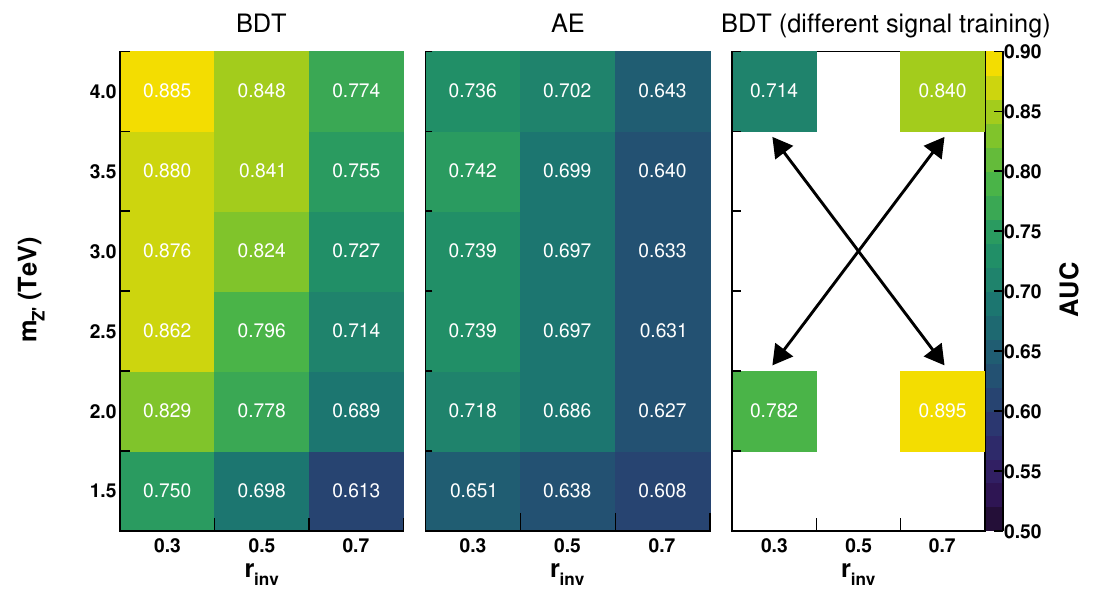
Figure 6. Left and middle panels: comparison of AUC values of the autoencoder and a BDT trained on a mixture of all signal models with m dark = 20 GeV. Right panel: AUC values for a BDT trained on a signal with parameters different from those it was tested on. E.g., the AUC value presented in the top left corner of the table comes from a model trained on the lower right corner